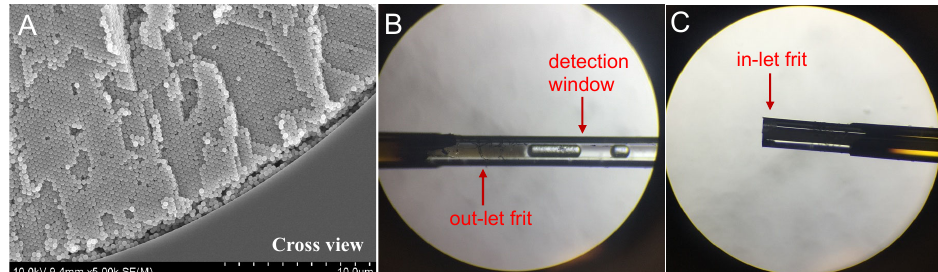
Figure 2. ( A ) SEM images of the cross ‐ view of a 100 μ m i.d. capillary packed with 420 nm particles. ( B , C ) Photo of a column packed with submicron particles under a microscope: ( B ) outlet frit and detection window and ( C ) inlet frit tip.